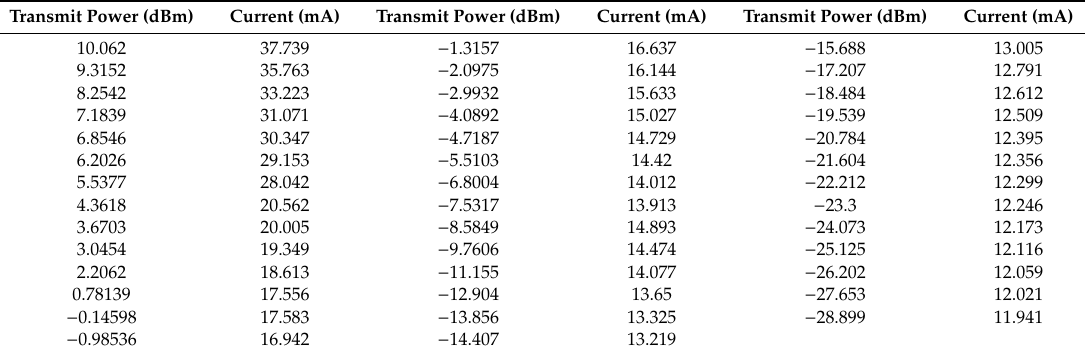
Figure 7. Comparison of the datasheet and measured values in the 121 segment transmission power. Table 3. Current consumptions in 41-segment transmission power.